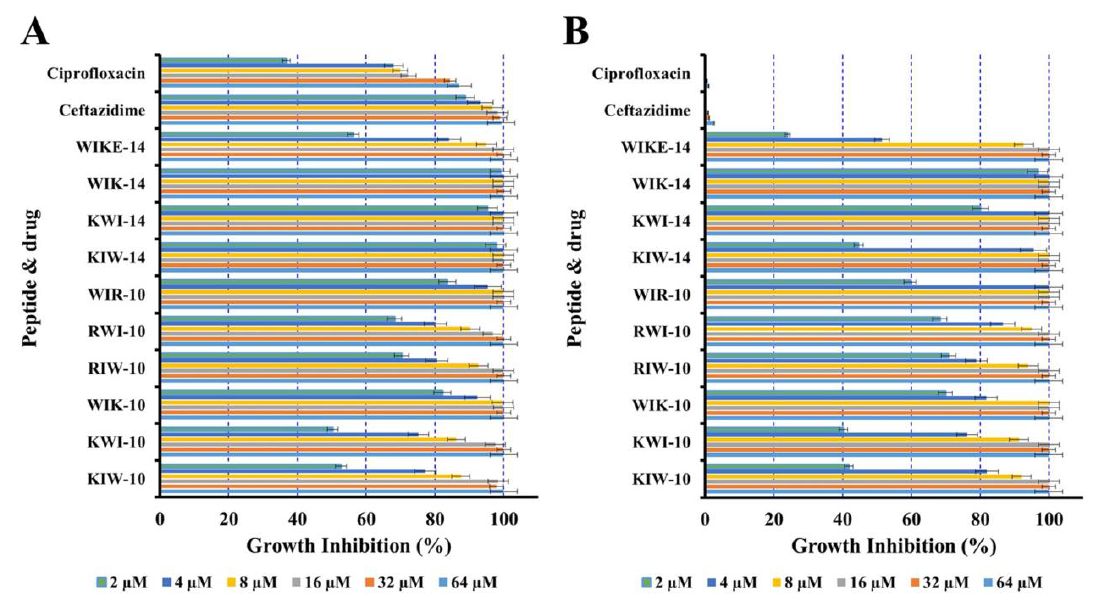
Figure 2. Growth-inhibitory effects of peptides and antibiotics in planktonic P. aeruginosa ATCC 27853 ( A ) or DRPa 4007 ( B ). ( A ) or DRPa 4007 ( B